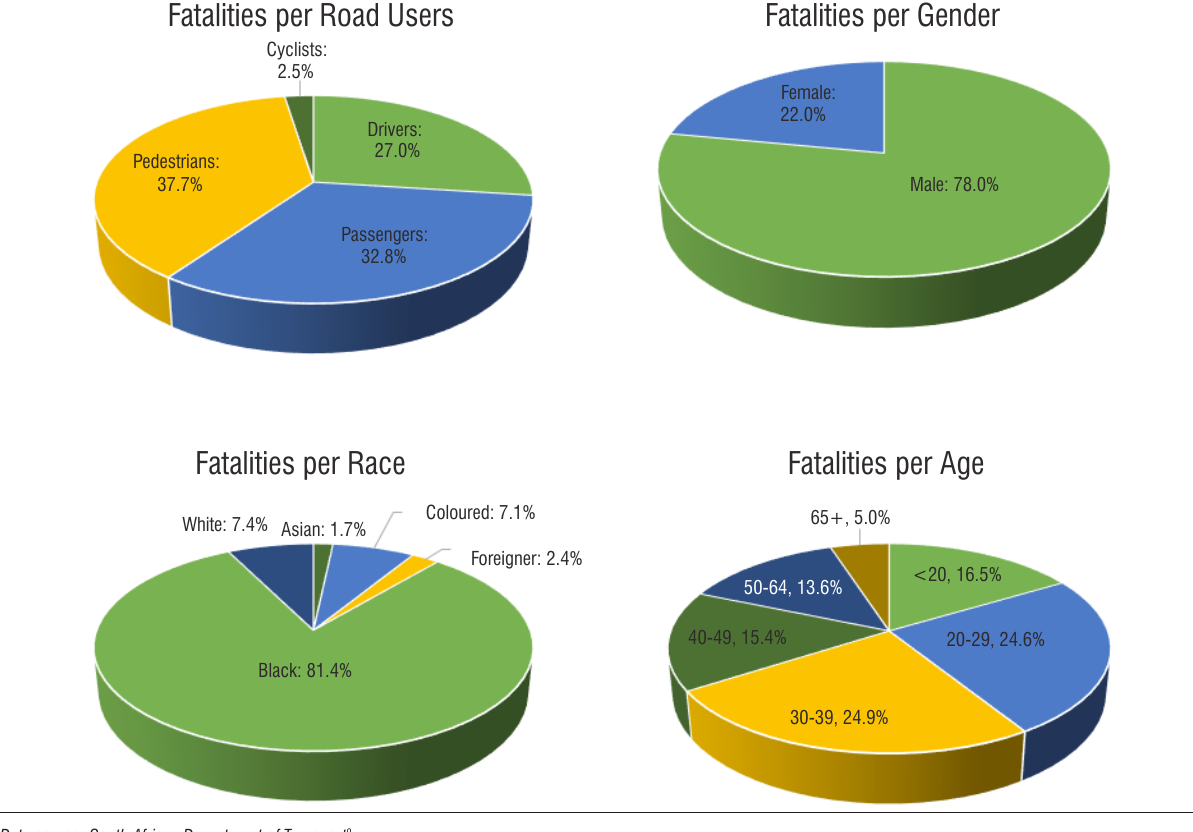
Data source: South African Department of Transport 9 Figure 4: Distribution of road fatalities per road users, gender, race and